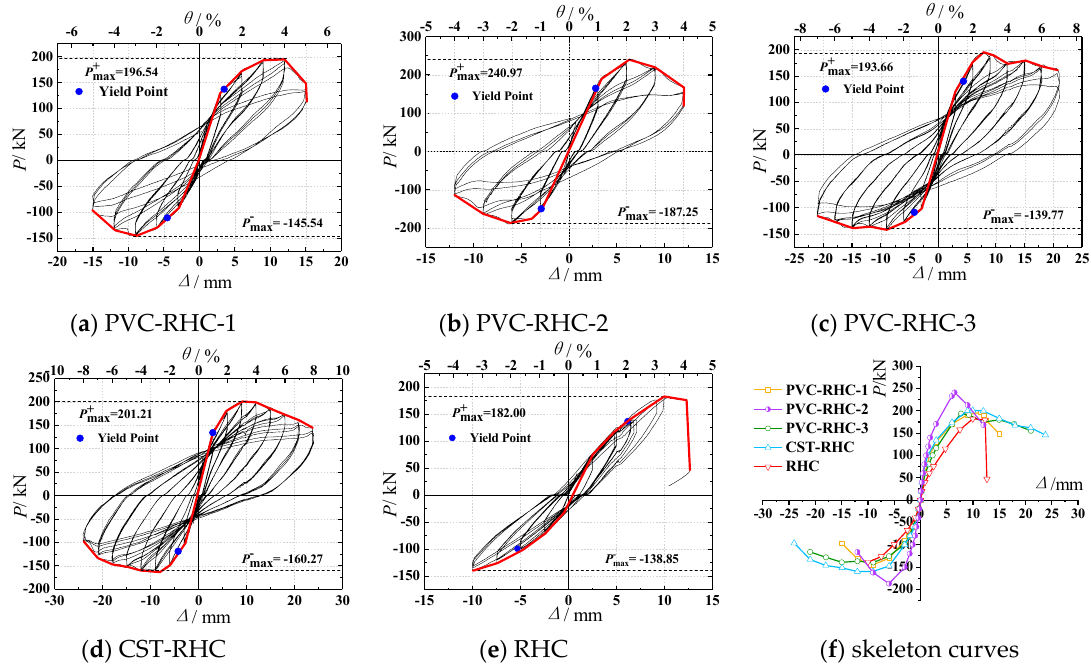
Figure 7. Hysteretic loops and skeleton curves of the specimen.